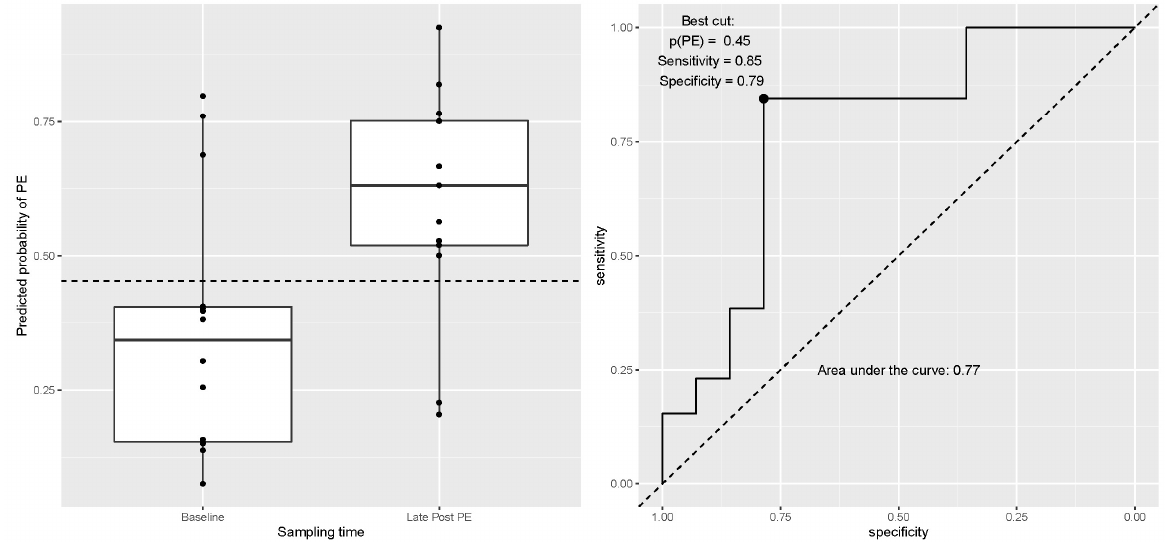
Figure 6. Boxplot and ROC curve for predicted probability of PE vs. true status at late post for PE samples. Predicted probabilities were obtained from the hold-out folds for the optimal model in the cross validation. Abbreviations: ROC = receiver operating characteristic, PE = pulmonary embolism, MS = mass spectrometry.